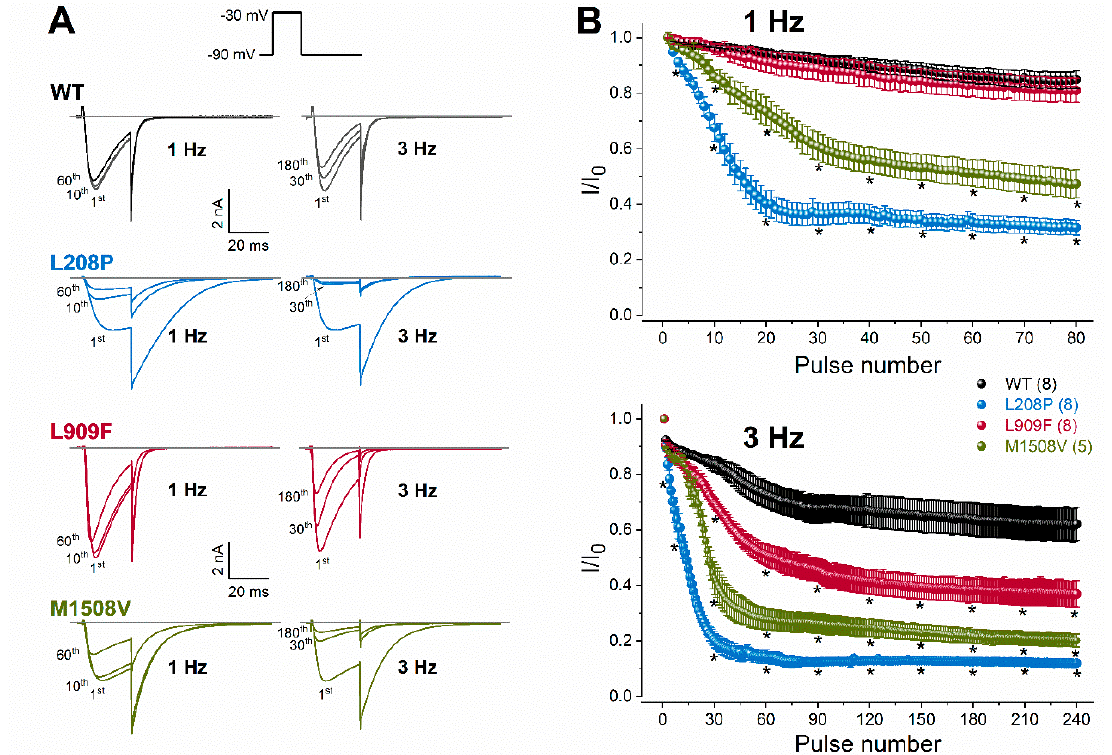
Figure 4. Rate-dependent changes in calcium current availability of WT and mutant Ca v 3.1 channels. ( A ), Representative whole-cell currents recorded during the 1st, 10th, and 60th depolarization at 1 Hz, or during the 1st, 30th, and 180th depolarization at 3 Hz. Inset: voltage protocol. Horizontal grey lines indicate zero-current levels. ( B ), Plots of normalized WT and mutant peak calcium currents as a function of the stimulus number for the 1- (top) and 3-Hz (bottom) stimulus rates. Currents were normalized to the first stimulus. Data are mean ± SEM; the number of experiments, n, is shown in parentheses; Selected mean current amplitude values, elicited by pulse number 1, 3, 10, 20, 30, 40, 50, 60, 70, and 80 during 1-Hz stimulation and pulse number 1, 3, 10, 30, 60, 90, 120, 150, 210, and 240 during 3-Hz stimulation were included in the statistical analysis. The p values of the ‘Ca v 3.1 variant ∗ pulse number’ interaction associated with current availability at 1 or 3 Hz were < 0.0001. Asterisks indicate statistically significant differences compared to WT ( p < 0.05 in two-way ANOVA followed by Dunnett’s post hoc test); see also Table 1.